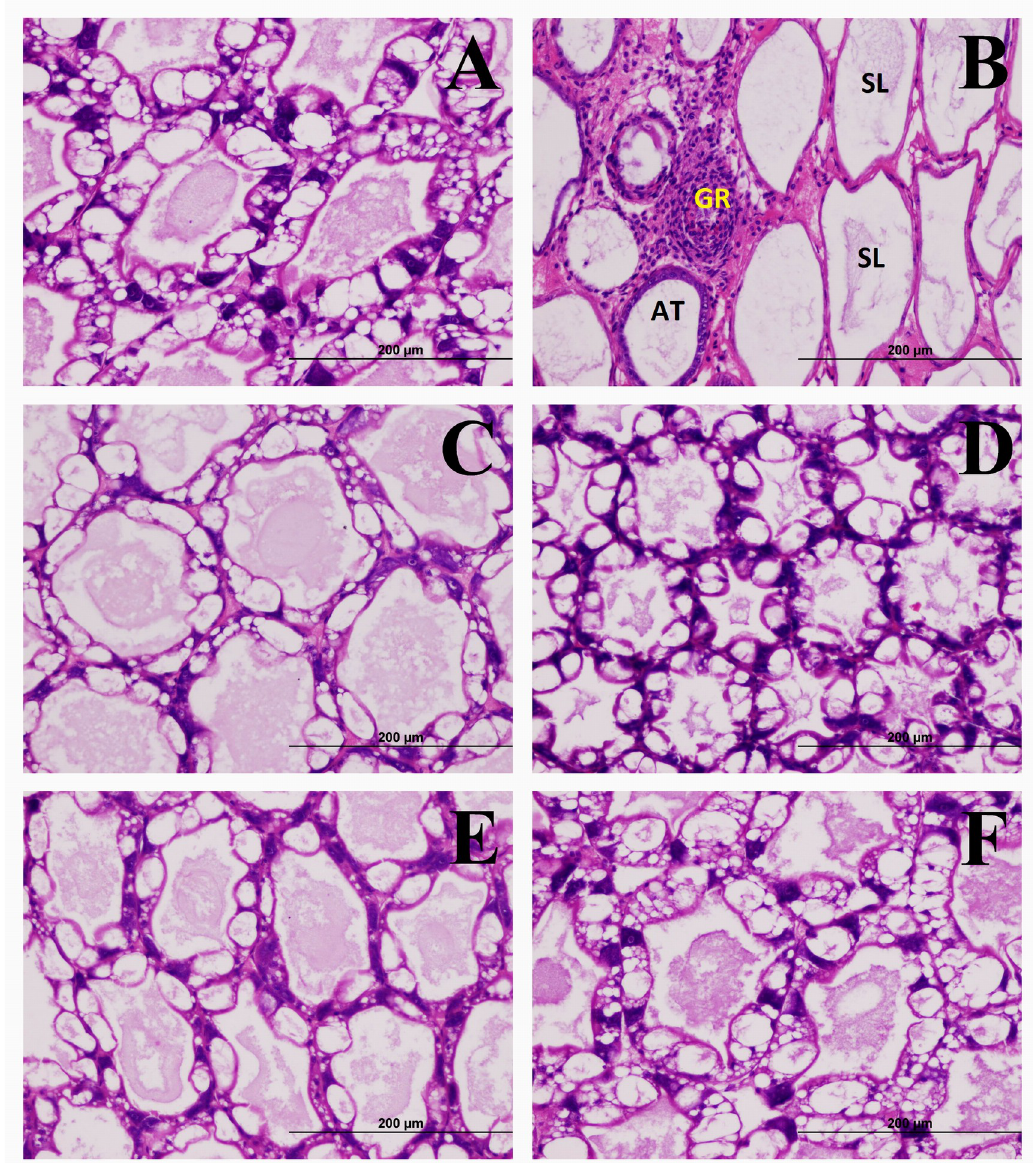
Fig 2. Effects of IQ extracts on histopathology of the hepatopancreas of the Vibrio parahaemolyticus -infected shrimp. Hepatopancreas of the shrimp fed the negative control diet ( A ), positive control diet showing atrophy (AT), sloughing of the hepatopancreas tubule epithelial cells (SL), and granulomatous encapsulation (GR) ( B ), IQ-E 200 mg/kg of feed diet ( C ), IQ-E 300 mg/kg of feed diet ( D ), IQ-WS 100 mg/kg of feed diet ( E ), and IQ-WS 150 mg/kg of feed diet ( F ) on day 14 after immersion challenge with Vibrio parahaemolyticus (10 3 CFU/mL) (H&E stain).